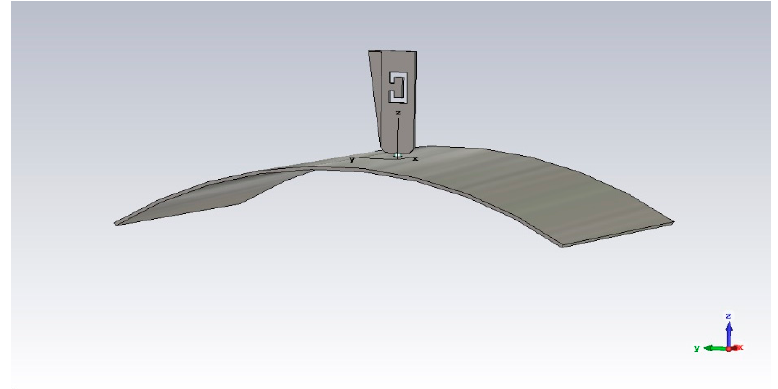
Figure 8. Bent ground plane, ‘Y’ direction (R = 275 mm, example)—perspective view.